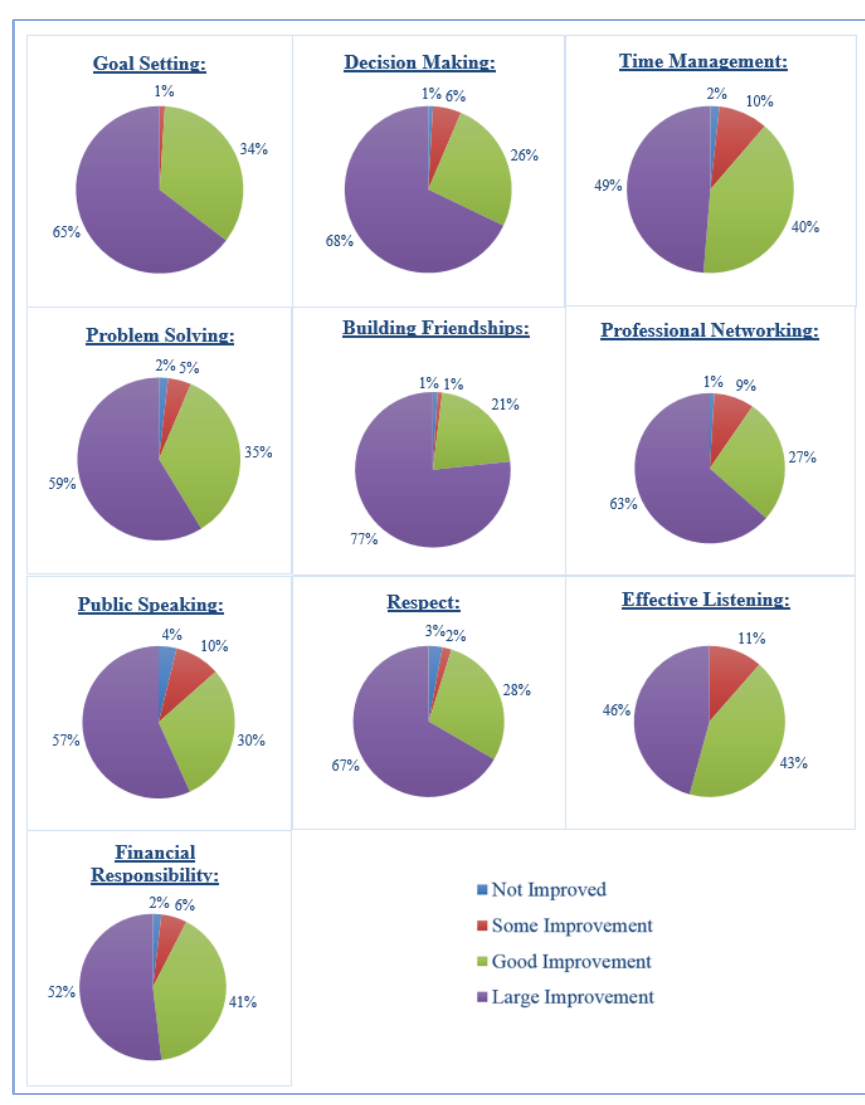
Figure 2. Participants’ Life Skill Development Through a Youth Livestock Sales